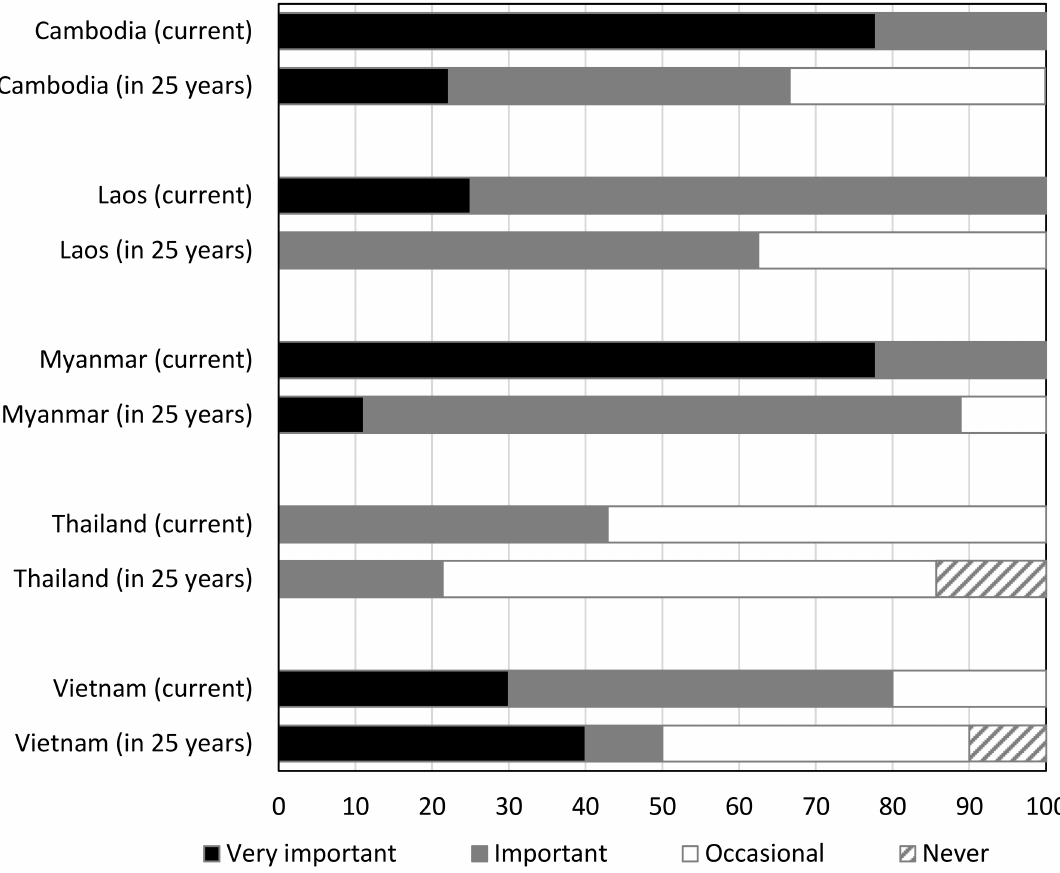
Figure 5. Importance of fuelwood, the most commonly used bioenergy feedstock for private use, currently (solid bars) and in 25 years (dashed bars). Values represent the percentage (share of all responses in each category). Data source: post workshop survey, authors’ compilation